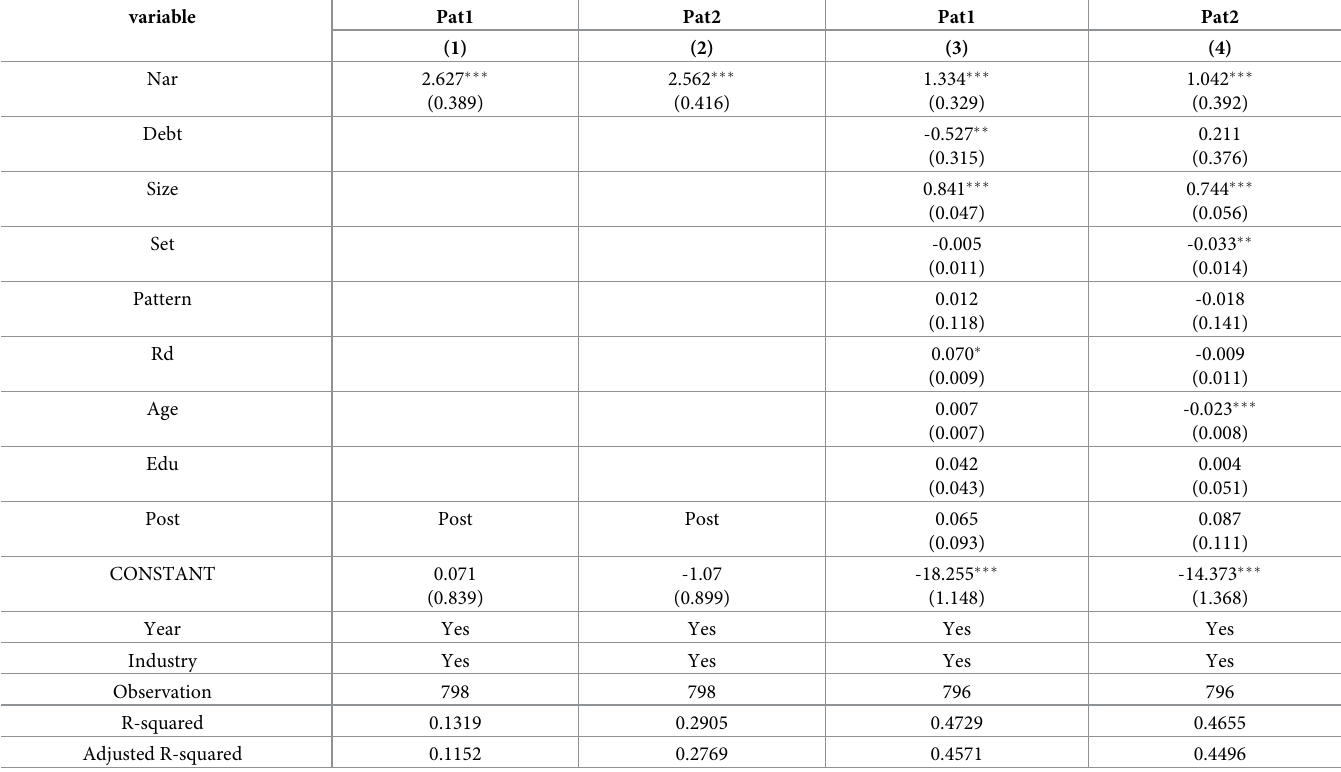
Table 5. Benchmark regression